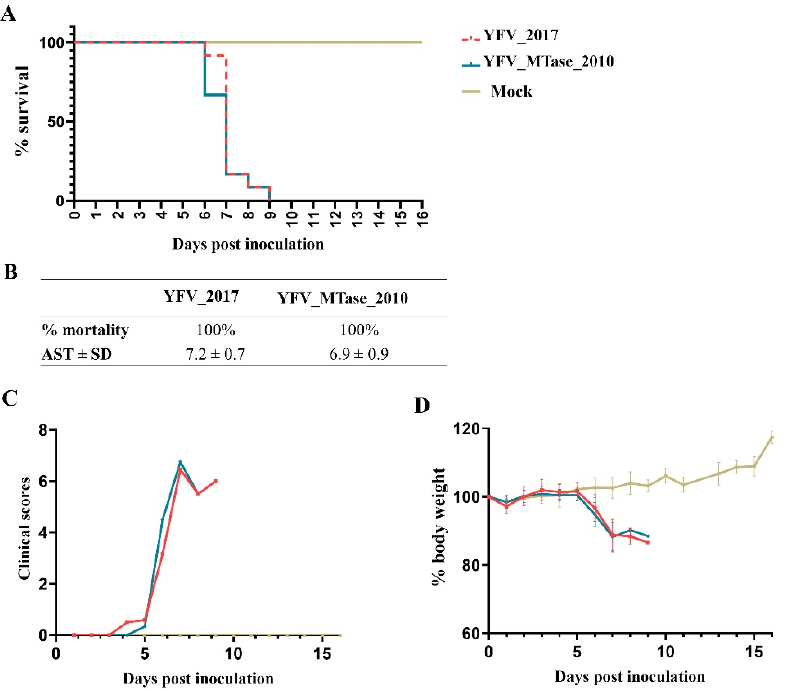
Figure 6. Neurovirulence in BALB/c mice after inoculation with YFV_2017 and YFV_MTase_2010. ( A ) Kaplan–Meier survival curves of animal groups inoculated with each virus and culture medium (Mock). ( B ) Table summarizing the results obtained from the survival curves. ( C ) Bodyweight measurements during the 16 days after inoculation. ( D ) Clinical scores of the animals until euthanasia.